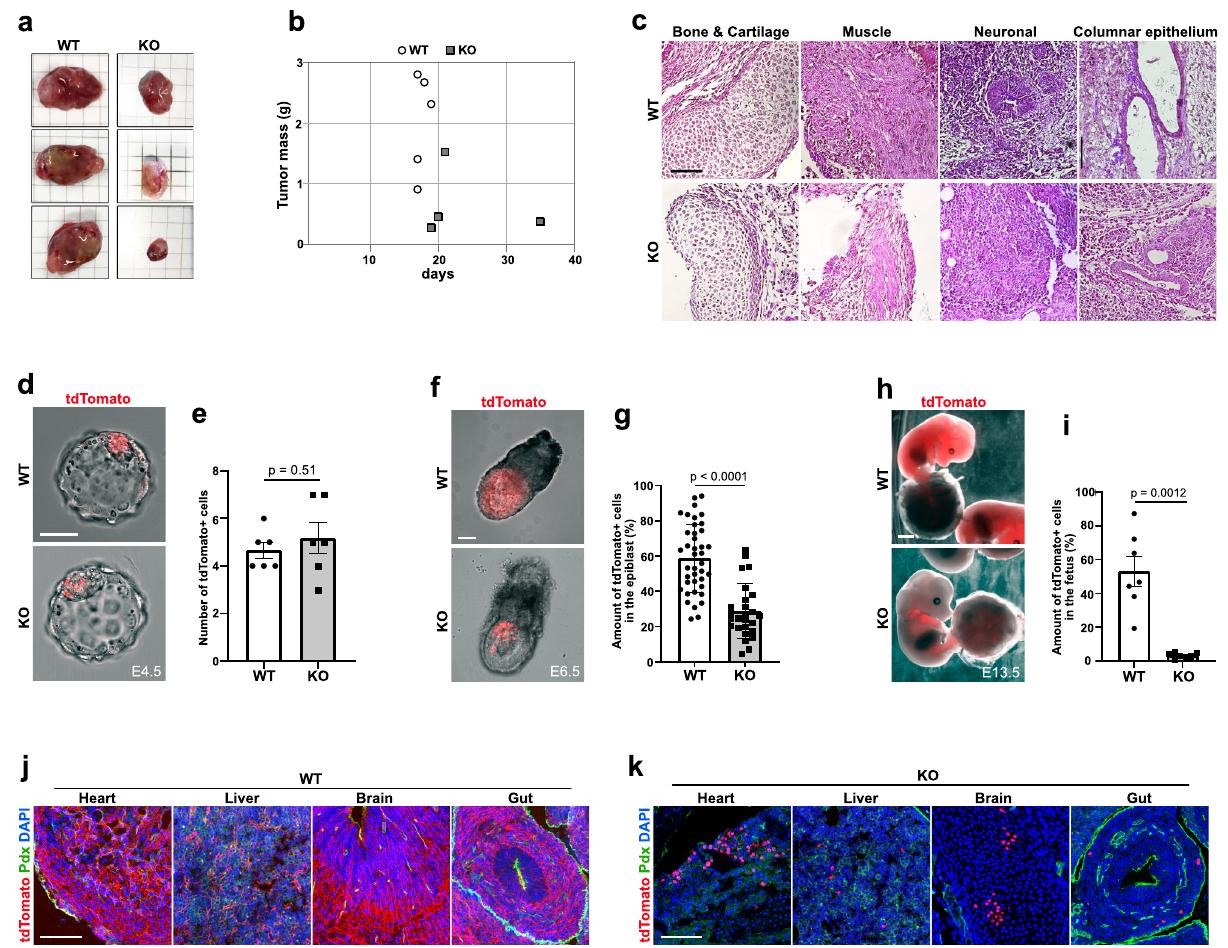
Fig. 4 Developmental potential of Lima1 KO ESC. a Teratomas derived from Lima1 KO or WT ESC. b Growth of WT and Lima1 KO teratomas. c Haematoxylin and eosin staining of sectioned teratomas. d Chimeric blastocysts containing control (WT) or Lima1 KO donor cells. e Quanti fi cation of integrated donor cells at blastocyst stage, data represent mean ± SEM, WT n = 6 embryos, Lima1 KO n = 6 embryos, unpaired Student ’ s t -test, 2-sided. f Chimeric E6.5 embryos containing control (WT) or Lima1 KO donor cells. g Quanti fi cation of the ectopic cells relative to the total epiblast cell number at E6.5. WT ( n = 40 embryos), Lima1 KO ( n = 32 embryos), three independent experiments. Data represent mean ± SEM, Mann – Whitney test, 2-sided. h Chimeric E13.5 embryos containing control (WT) or Lima1 KO donor cells. i Quanti fi cation of the ectopic cells relative to the total cell number of the foetus, determined by fl ow cytometry. WT ( n = 7 embryos), Lima1 KO ( n = 7 embryos), three independent repetitions. Data represent mean ± SEM, unpaired Student ’ s t -test, 2-sided. j Chimeric E13.5 embryos containing WT donor cells, stained for tdTomato, Podocalyxin and DAPI. k Chimeric E13.5 embryos containing Lima1 KO donor cells, stained for tdTomato, Podocalyxin and DAPI. Scale bars, ( c ) 50 μ m; ( d ), 20 μ m; ( f ) 50 μ m; ( h ) 1000 μ m; ( j ), ( k ),100 μ m; Experiments were repeated independently three times ( c, j, k ) with similar